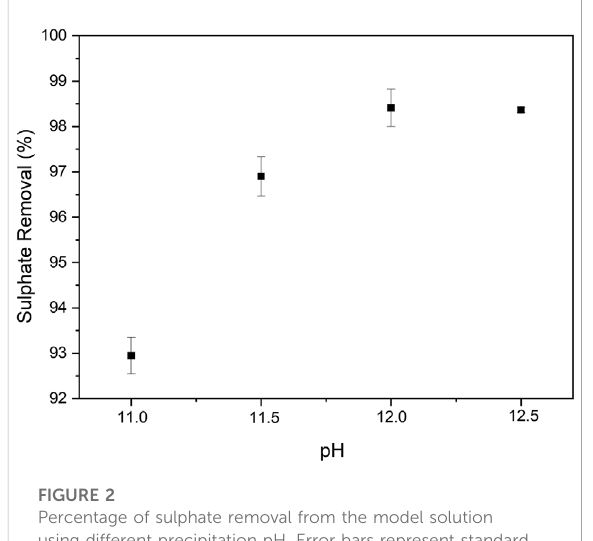
FIGURE 2 Percentage of sulphate removal from the model solution using different precipitation pH. Error bars represent standard deviation ( n = 2).